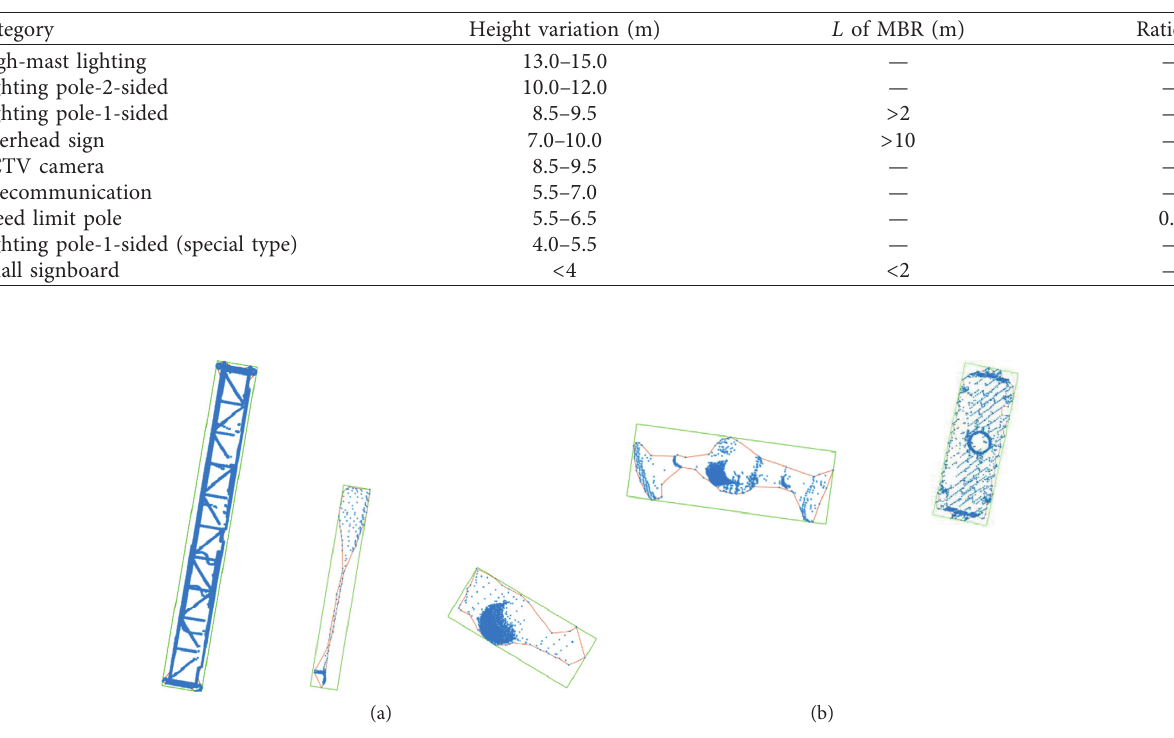
Figure 11: Bounding box of 2D projected points of PLOs in the horizontal plane (from left to right). (a) Group of PLOs with the same height (7–10m): overhead sign, lighting pole-1-sided, and CCTV camera. (b) Group of PLOs with the same height (5.5–6.5m): telecommunication tower and speed limit pole.